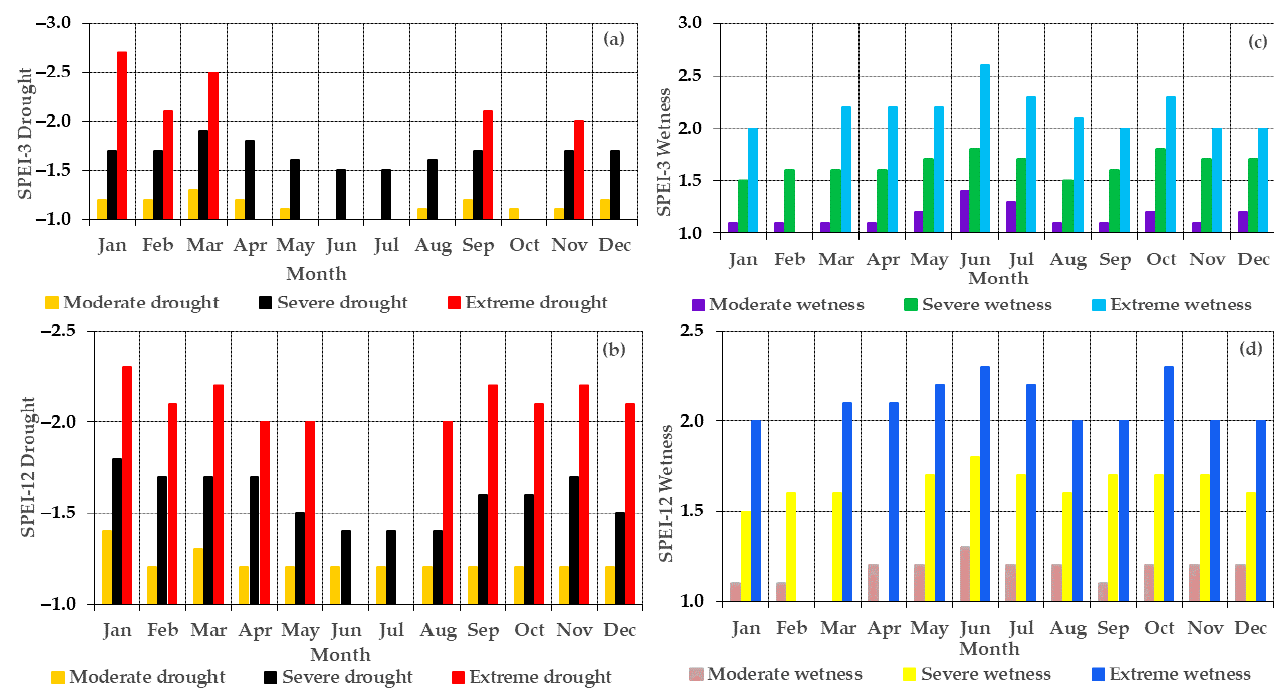
Figure 3. Temporal evolution of the mean monthly SPEI-3 and SPEI-12 for moderate, severe, and extreme drought ( a , b ) and wetness ( c , d ) from 1981 – 2021 over the coastal Savannah agroecological zone in Ghana.